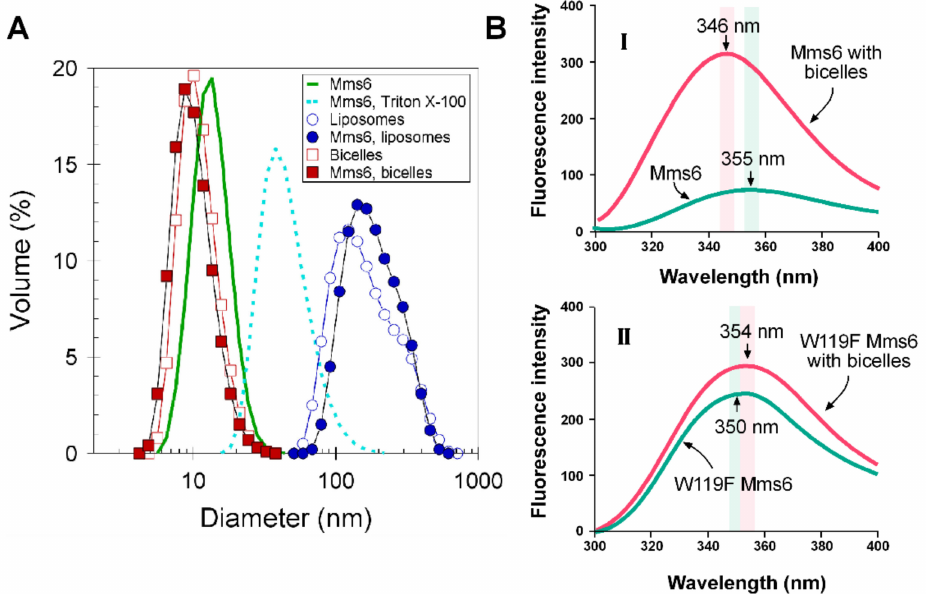
Figure 5. Mms6 interaction with lipids: ( A ) dynamic light scattering analysis of samples (500 µ L in 20 mM Tris, 100 mM KCl, pH 7.5) of 25 mM bicelles, 2 mM liposomes or 0.5% Triton X100 with or without 20 µ M Mms6 as stated in the legend on the figure. Size distributions for each sample are shown as a volume percentage; ( B ) fluorescence spectra were collected ( λ ex = 290 nm) and analyzed as described in Materials and Methods. Smoothed curves are shown for the fluorescence intensity of Mms6 ( I ) or W119F Mms6 ( II ). The vertical pink and green bars identify the positions of the maximum fluorescence intensity ( ± 2.5 nm, based on a slit width of 5 nm) for each peak colored in red and green,